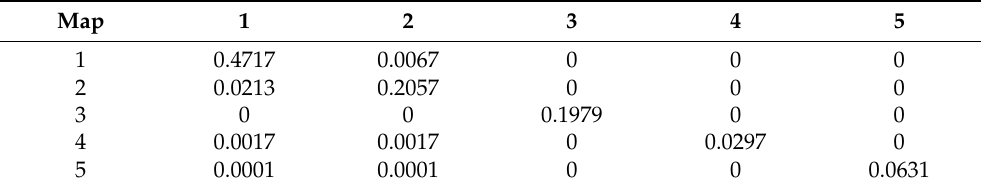
Table 3. The initial prejudgment error matrix.